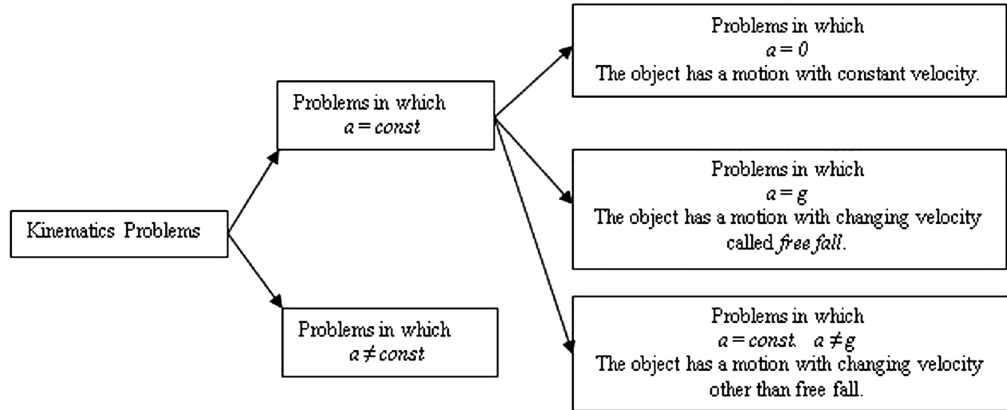
FIG. 3. Possible classification scheme for kinematics problems.